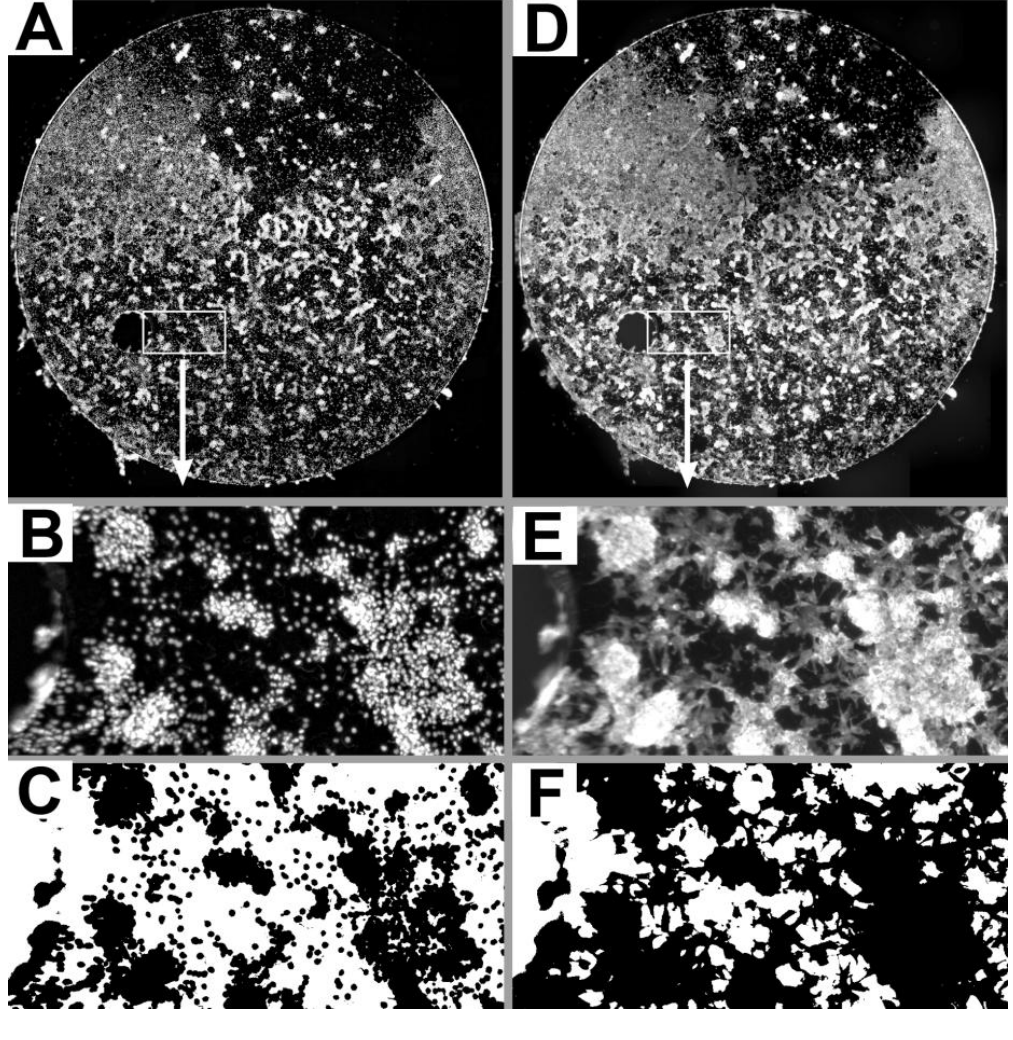
Figure 1. Low power composite images of DAPI stained nuclei ( A ) and FITC-labeled actin ( D ) of one etched titanium platelet (see also Figure 2 F). The boxed 1350 µm* 675 µm regions in the low power overviews are shown at higher magnification for nuclei ( B ) and actin ( E ). In the binary images ( C,F ) corresponding to B and E, pixels with gray levels above the respective gray level threshold (see methods) are shown in black. Using adequate threshold settings DAPI stained nuclei ( C ) and FITC-labeled actin ( F ) were well discriminated from the surface of the platelet not covered by nuclei or cytoplasm (shown in